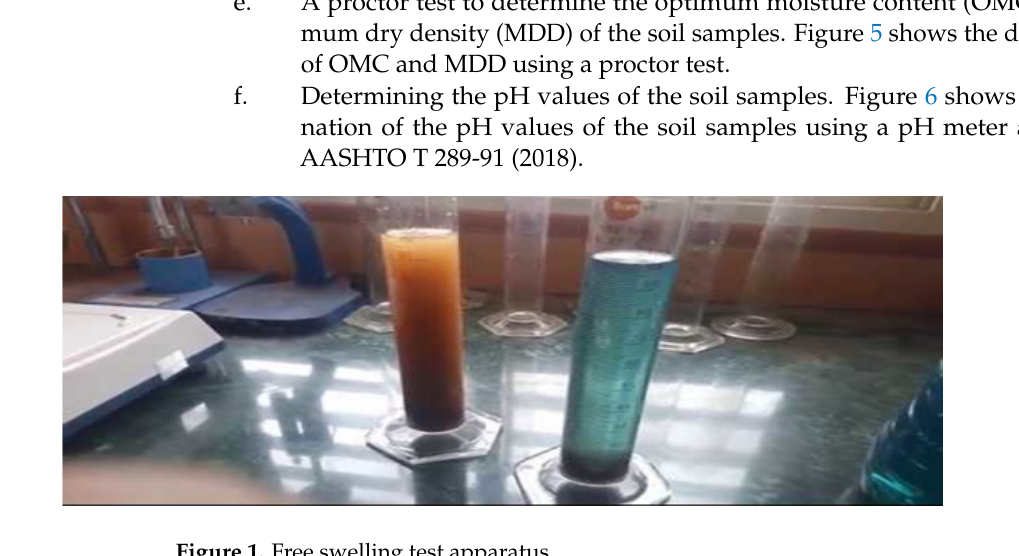
Figure 2. The grading curves of natural soil, natural sand, and the treated soils with different per- centages of sand.